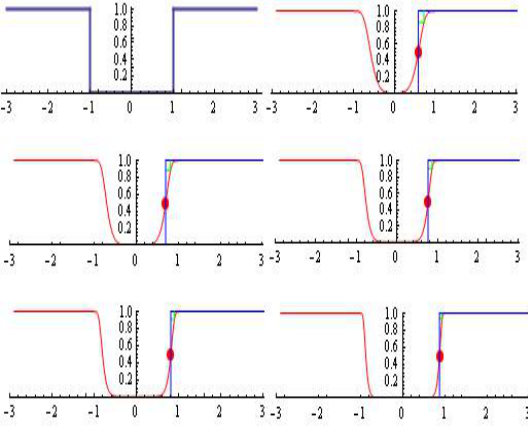
Fig. 8. The recurrence generated family: A 0 ( t ) (blue), A 1 ( t ) (red) and A 2 ( t )